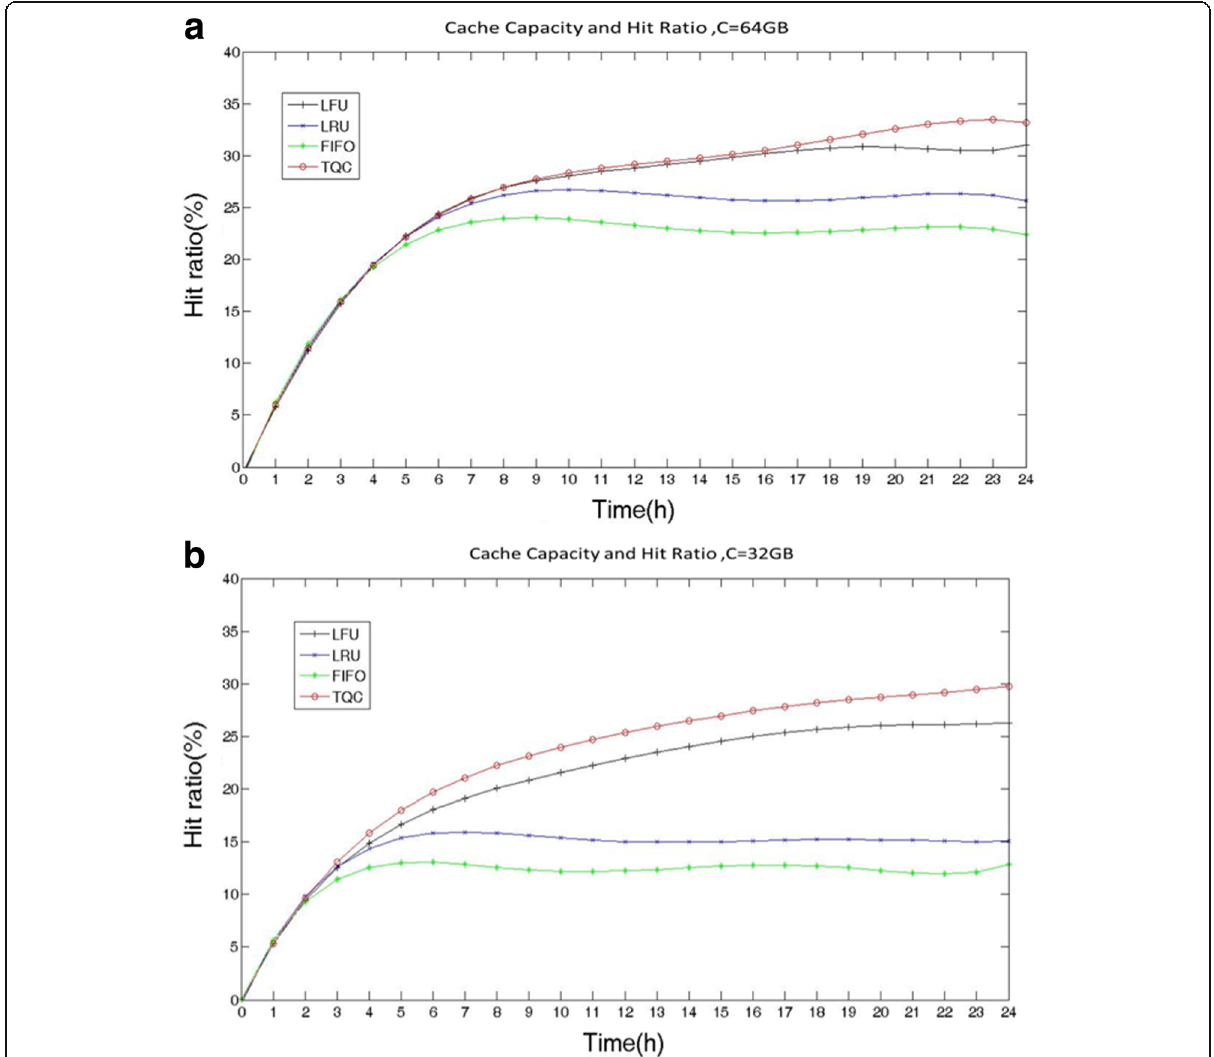
Fig. 3 Effect of cache capacity on hit ratio. The figure shows the comparison for the cache hit ratios of different policies when request rate is 500 times/ min and the cache capacity C is 64 GB and 32 GB respectively. It can be seen that LRU, LFU, FIFO, and TQC policies all have the same hit ratios when the cache is not full. When t_full=4.5 h, C =64 GB, t_full=2.5 h, C =32 GB, and the cache is full, different replacement policies start replacing the contents. a and b , consequently, the hit ratios of LRU, TQC, and LFU begin to increase and that of FIFO gradually decreases. In general, the performance of TQC is better than the other three policies. When there is hotspot data, the efficiency of LRU is very good. But sporadic and periodic batch operations will lead to a sharp drop of LRU hit ratio and a serious pollution of the cache. FIFO does not take into account the characteristics of data popularity, so its hit ratio reaches peak of 25% and 12.5% at t_full, then begins to decline and fluctuates around 22.5% and 12.5%. Although the hit ratios of the two are not very different, compared with TQC, LFU records all the access counts of files and as the cache capacity increases, LFU needs to cost more. Therefore, TQC saves more time than LFU and the hit ratio of TQC is also about 12% higher than that of traditional